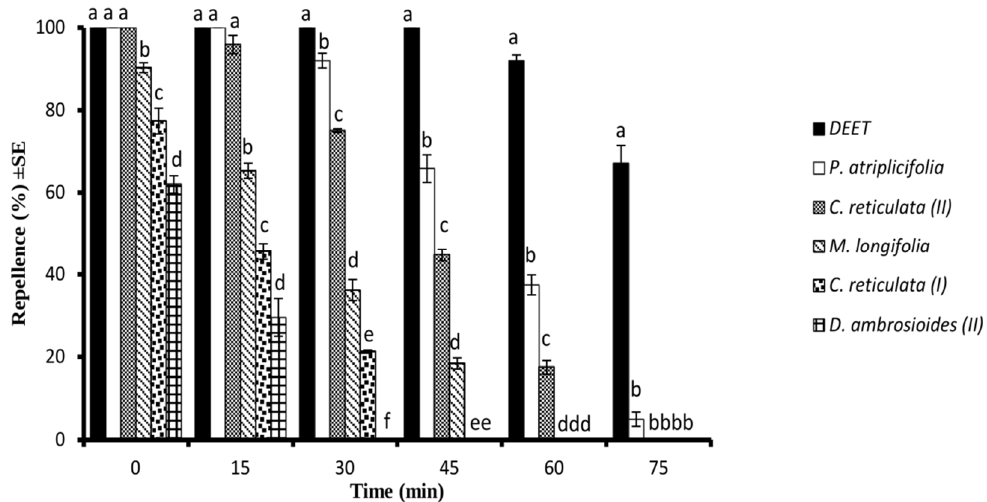
Figure 2. Time span mosquito repellency of different essential oils and DEET at the tested concen- tration of 33 µ g/cm 2 against Ae. aegypti females. Different letters on the bars show a significant difference ( p < 0.05) among different test substances at a specific period. Error bars on each column represent standard error where n = 5.